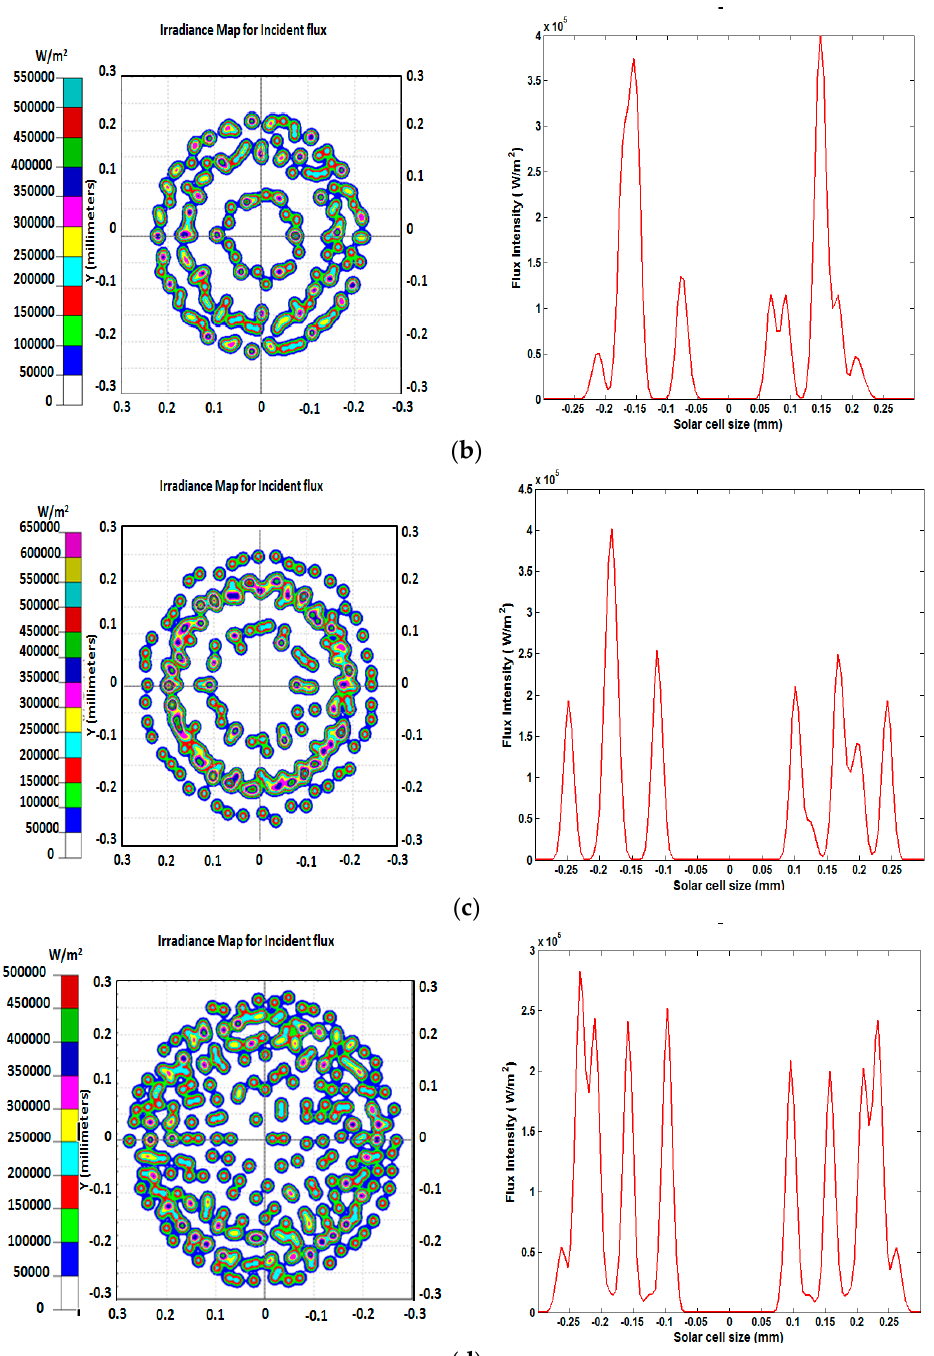
Figure 4. Flux distributions depending on the prism number. ( a ) Prism number = 3; ( b ) Prism number = 6; ( c ) Prism number = 12; ( d ) Prism number = 30.